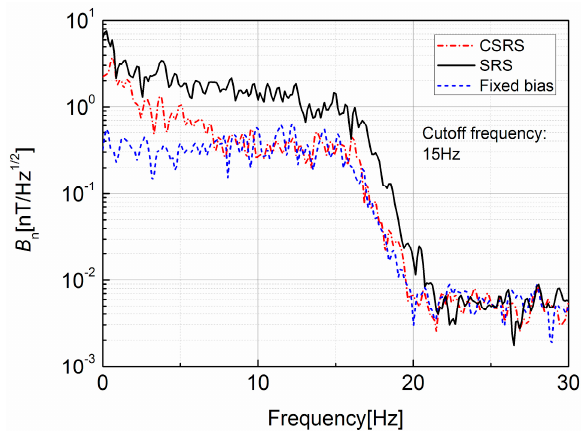
Figure 11. The noise spectral density of GMI sensors.